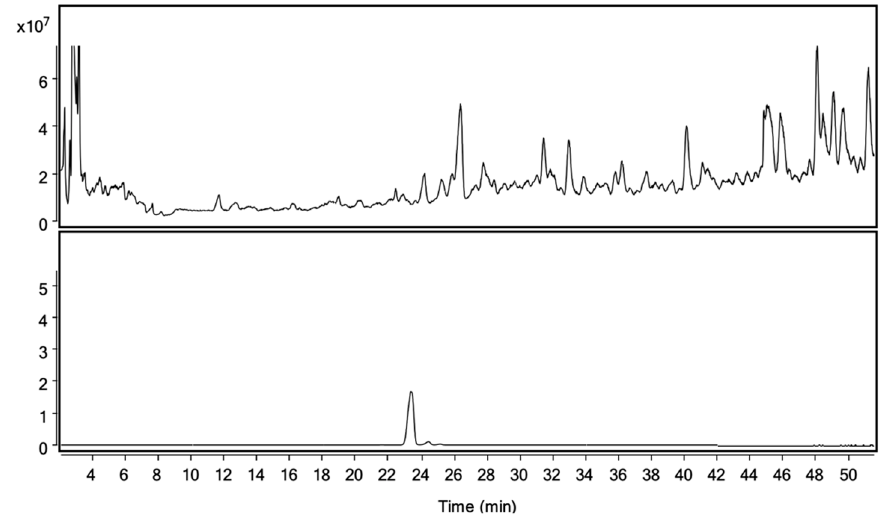
Figure 4. LC-MS total ion chromatogram (TIC) of commercial sage extract (7:3, v/v ; methanol:water) (top). TIC of purified benzyl 6-O- β -D-apiofuranosyl- β -D-glucoside (B6AG, >90% purity) (bottom).